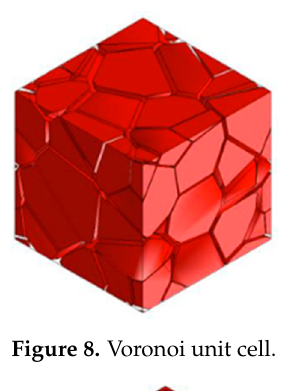
8 of 16 Figure 7. Algorithm for intersecting a Voronoi cell (VC) and the unit cell (UC). In each RVE, a comprehensive 3D model of the GI and GB phases as randomly-distributed sub- volumes was developed (Figure 8). As referenced above, the VF of GI and GB phases play a significant role on the calculated mechanical response of the RVE. These VFs could be parametrically